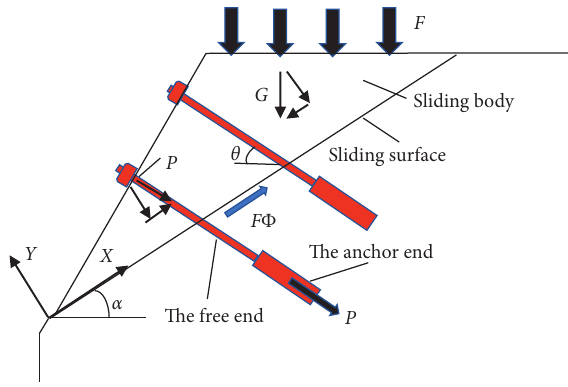
Figure 10: Schematic diagram of the mechanical